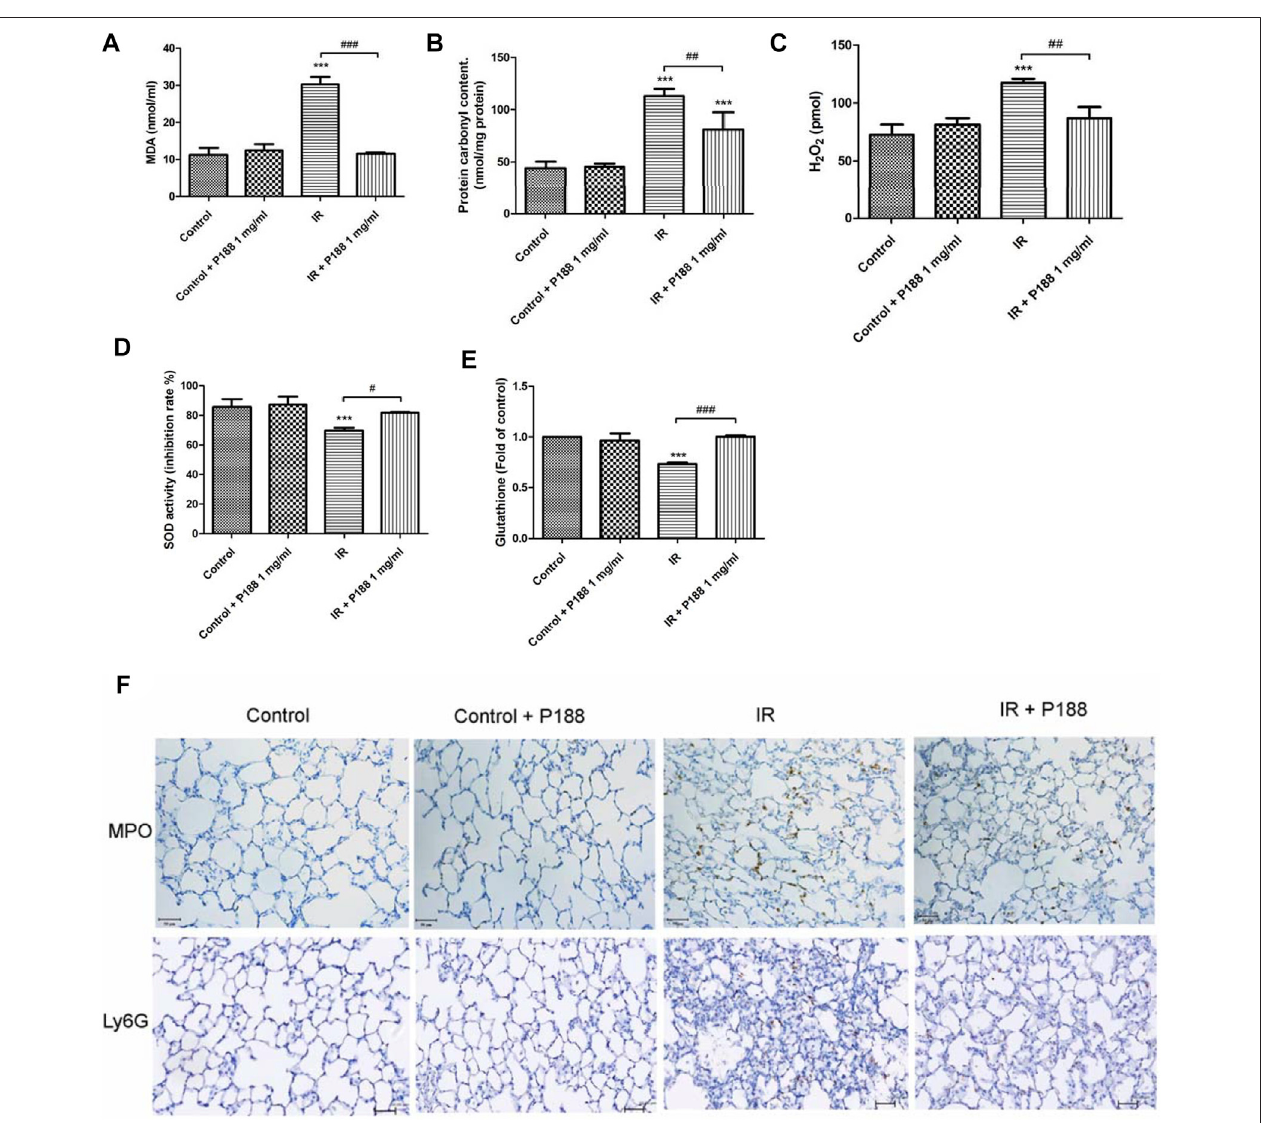
FIGURE3| EffectofP188onoxidativestressandthenumberofMPOandLy6G-positivecellsinlungtissues.Quanti fi cationoftheMDAlevel (A) ,carbonylcontent (B) ,H 2 O 2 concentrations (C) ,SODactivity (D) ,andGSHlevels (E) inthelungtissuewereperformedafter60 minreperfusion. (F) ImmunohistochemicalstainingsofMPO and Ly6G were performed after 60 min reperfusion. Representative images ( × 200 magni fi cation) are shown. Scale bar (cid:2) 50 µm. Data are mean ± SD (6 rats per group); *** p < 0.001 compared with the control group; # p < 0.05, ## p < 0.01, ### p < 0.001 compared with the IR group.